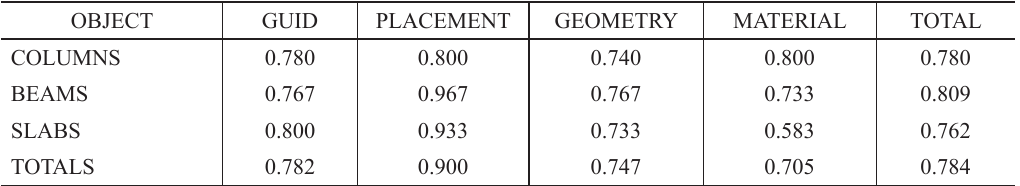
Table 2. Results from the second experiments